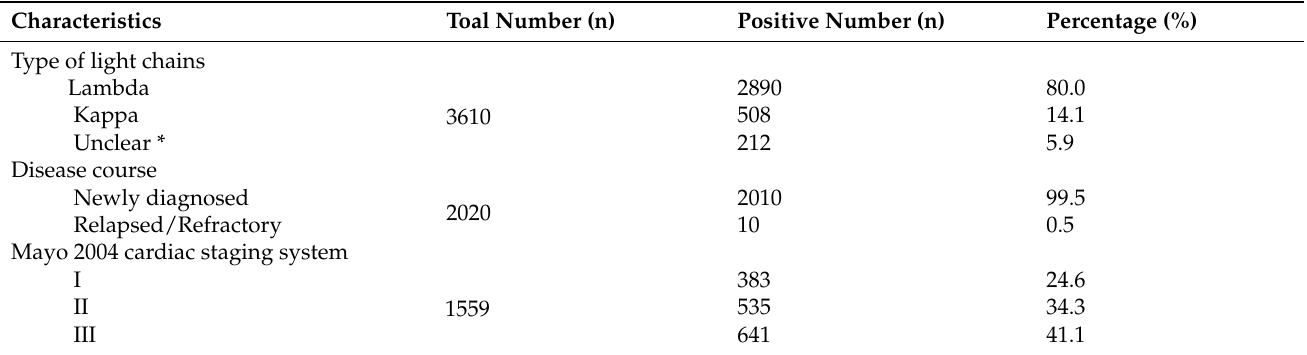
Table 1. Summary of clinical characteristics of